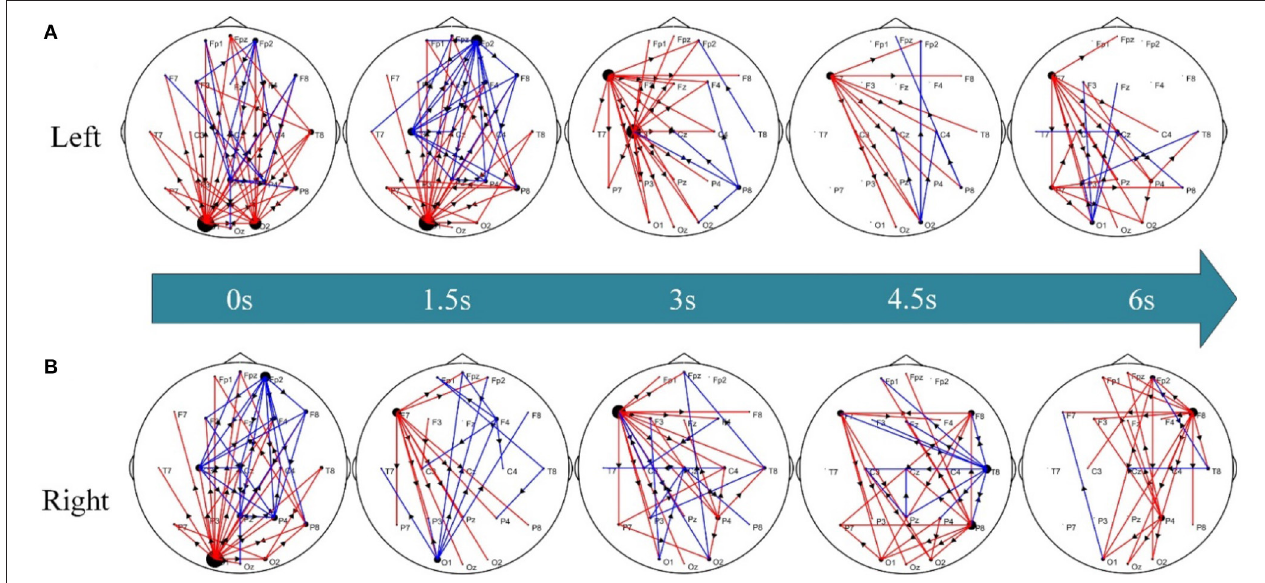
FIGURE 4 | Differential time-varying network topologies between the pairwise groups. (A) LS vs. HC groups and (B) RS vs. HC groups. Here, the red edge represents the connection edge where LS/RS is stronger than HC, the blue edge denotes the connection edge where HC is stronger than LS/RS, and the arrow indicates the information flow between